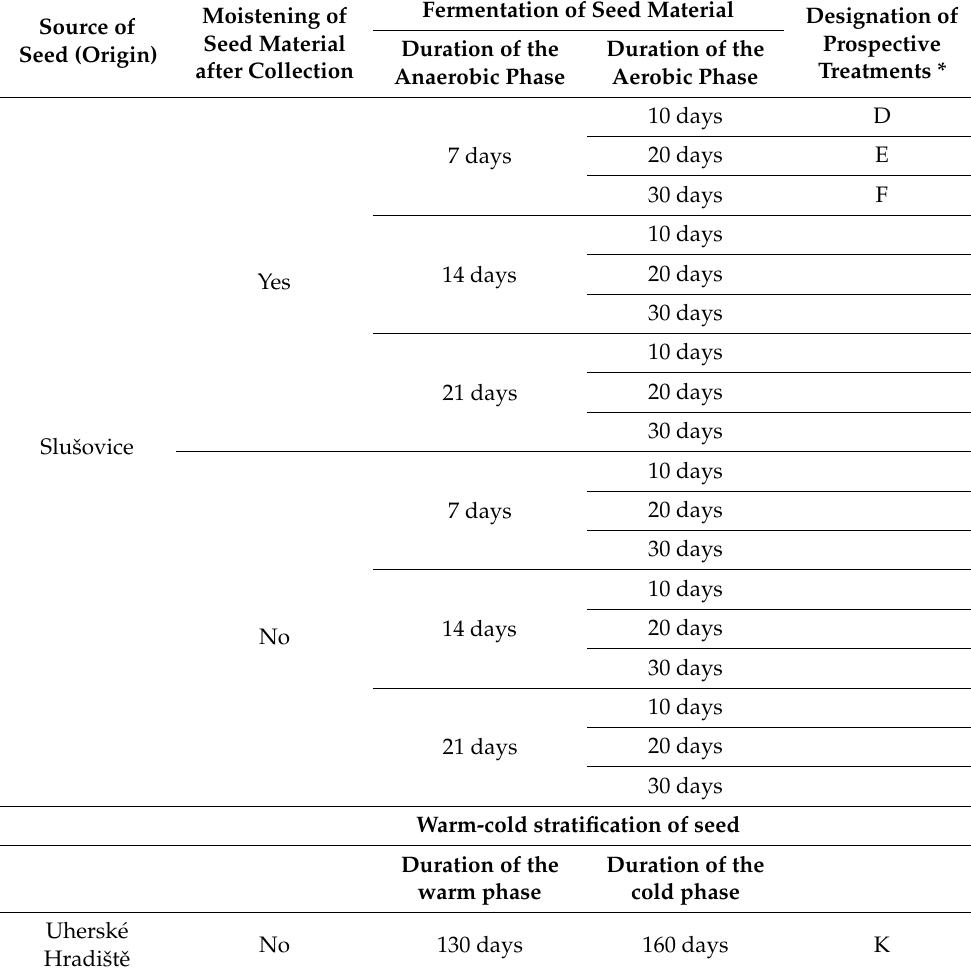
Prospective Treatments